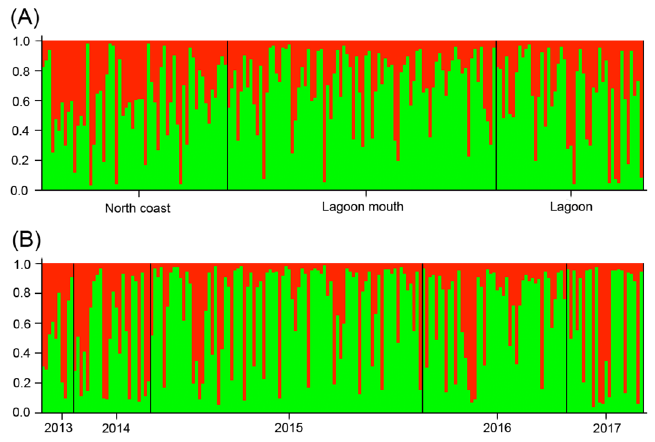
Figure 2. Assignment test performed by STRC TUR E under K = 2